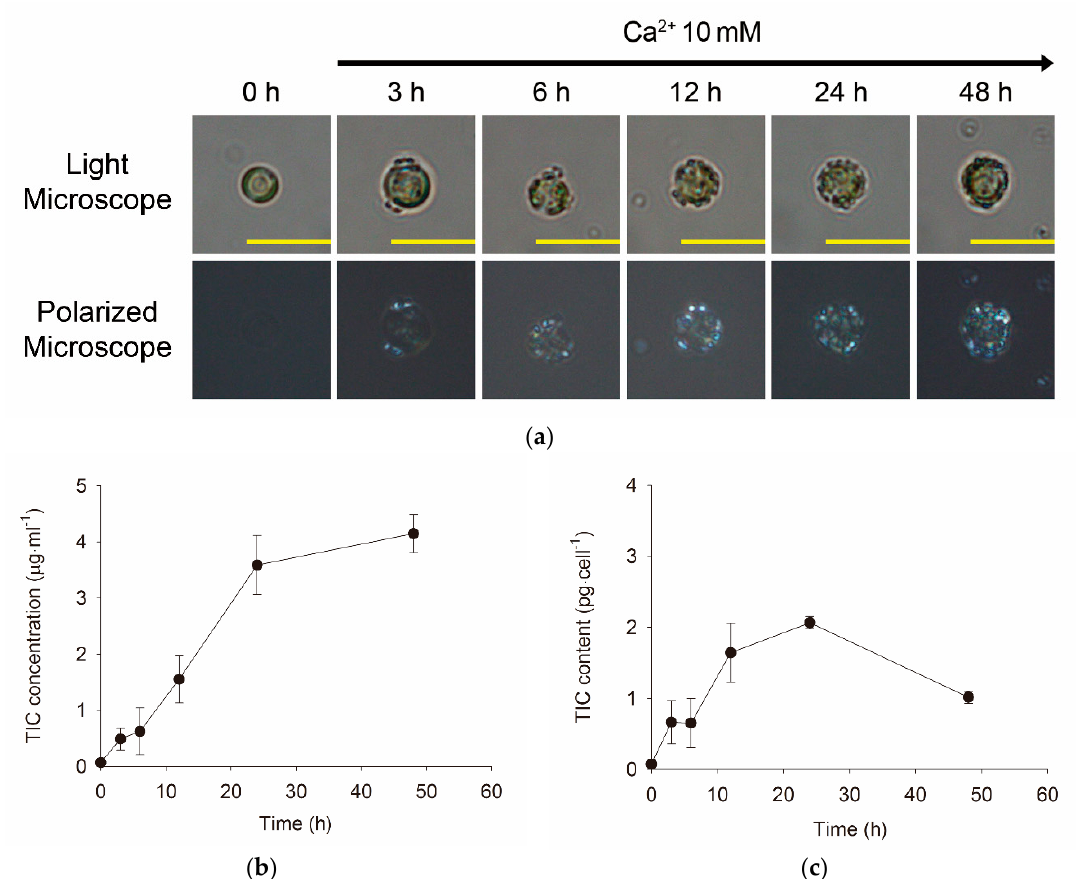
Figure 2. Rebuilding of the coccosphere and TIC of E. huxleyi CCMP 371 cells after transferring cells grown in low [Ca 2+ ] to the ambient [Ca 2+ ] conditions. ( a ) Whole-cell images under light and polarized microscopes. The yellow bar indicates a 10- μ m scale. ( b ) TIC concentration in the cell fraction, namely cells with coccoliths (Cell IC/mL cell fraction). ( c ) TIC content in a cell (Cell IC per cell).